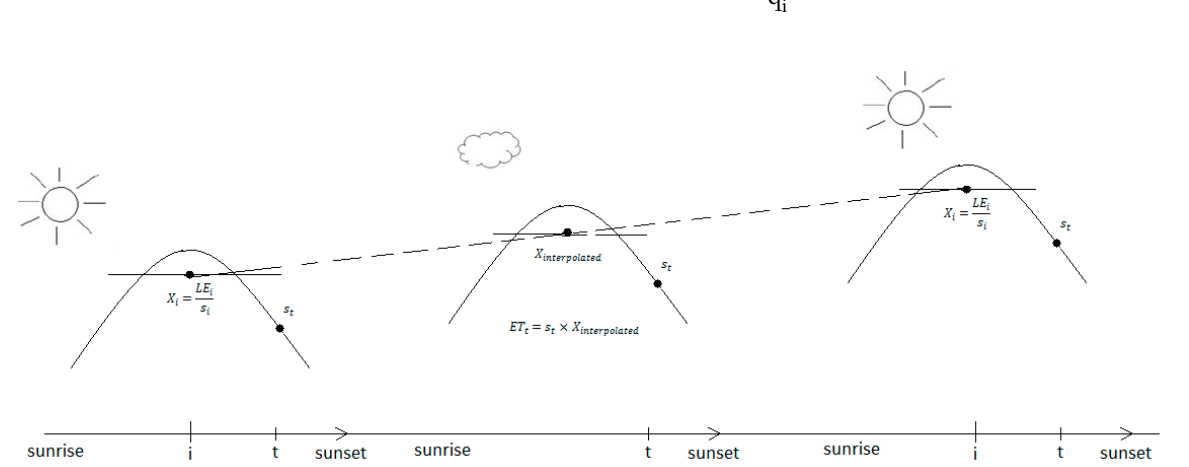
Figure 1. Illustration of the method to retrieve ET on days with no data acquisitions. The instantaneous scaling factor X is interpolated between two acquisitions.